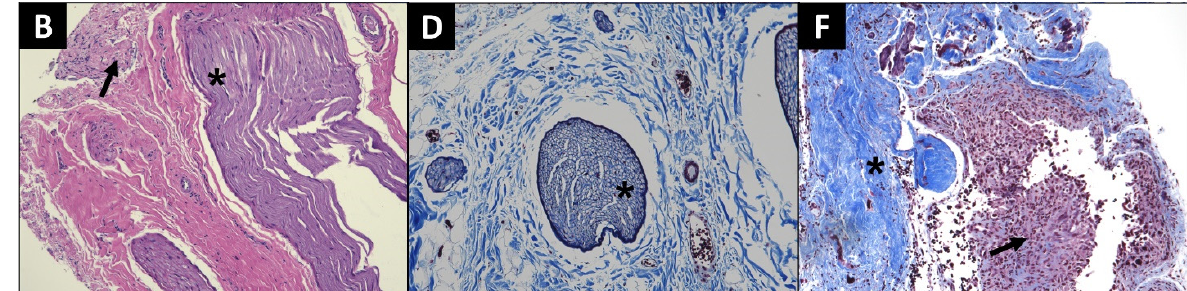
Figure 5. Light microscopy images of facial nerve collected after terminal experiments of Cat A (A–D) and Cat B (E,F) . (A) Left upper facial nerve (star) section collected adjacent to electrode and nerve injury site demonstrating granulomatous tissue formation (arrow) with neutrophilic infiltrate; Trichrome, 10×. (B) Left lower facial nerve (star) adjacent to electrode and nerve injury site showed increased collagen between nerves with peripheral neutrophil infiltrate and granulation tissue (arrow); H&E, 10×. (C) Left facial nerve (star) adjacent to nerve cuff implant/nerve injury site which received chronic stimulation demonstrating peripheral buildup of granulation tissue (arrow); Trichrome, 10×. (D) Right upper facial nerve (star) that received no injury and no electrode implant. This section was taken from approximately the same level as the left sided implant and shows normal tissue morphology; Trichrome, 10×. (E) Right lower facial nerve (star) that received no injury and no electrode implant. This section was taken from approximately the same level as left sided implant and shows normal tissue morphology; Trichrome, 10×. (F) Axonal fibers (star) of right facial nerve adjacent to nerve cuff implant/nerve injury site which received no chronic stimulation demonstrating peripheral buildup of granulation tissue (arrow); Trichrome, 10×. Scale bar = 200 μ m.